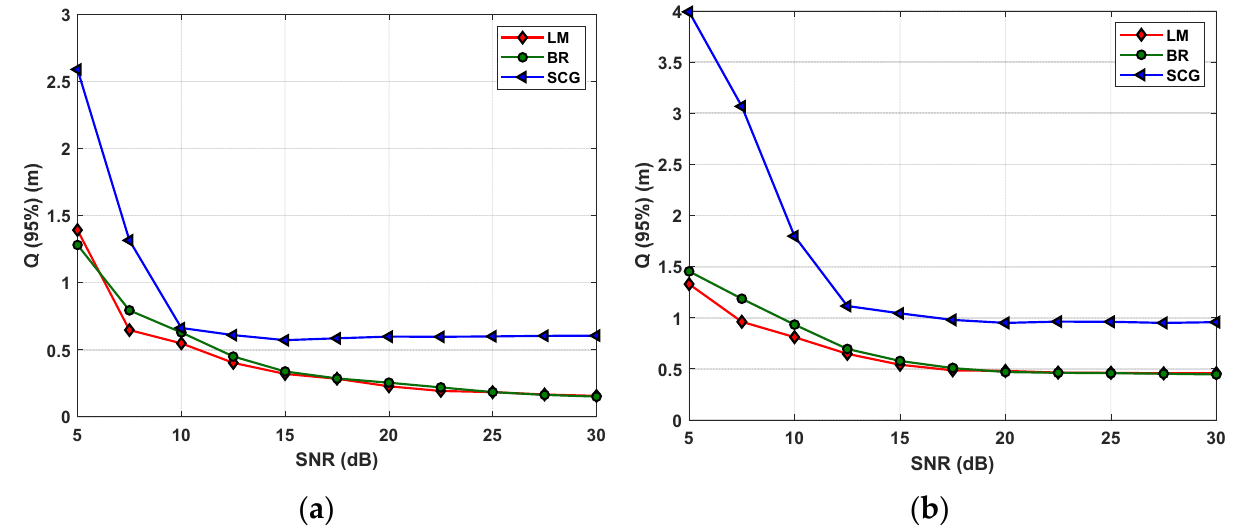
Figure 6. The measured 95% quantile function for different ANN algorithms for: ( a ) the inner; and ( b ) the outer regions.